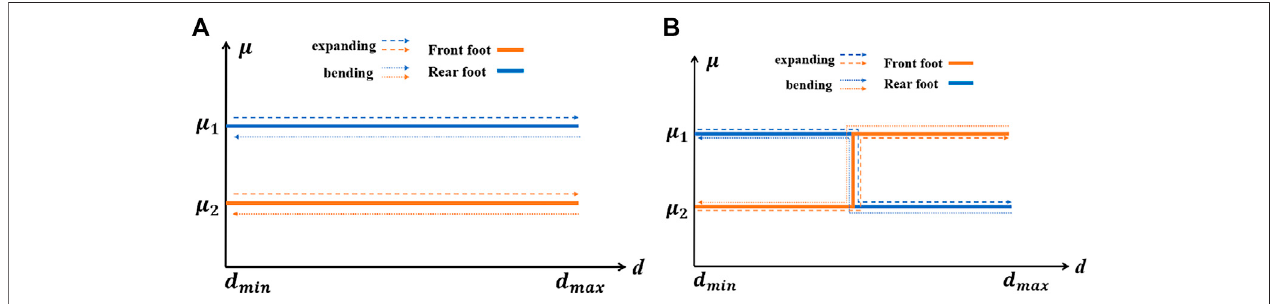
FIGURE 6 | Relationship between friction coef fi cients and distance of (A) the robot with two single friction coef fi cient feet and (B) the robot with antisymmetric variable friction coef fi cient